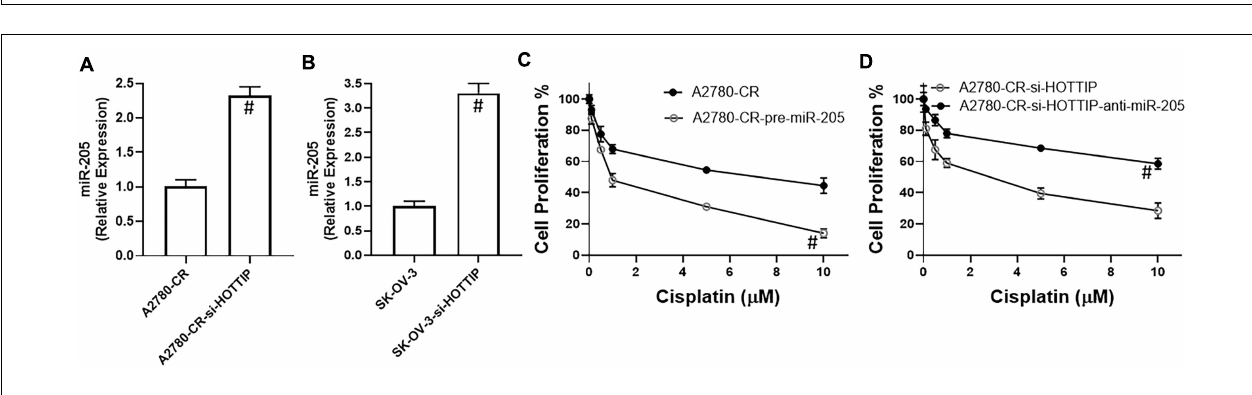
FIGURE 3 | Expression of miR-205 in (A) Cisplatin resistant A2780-CR cells (with and without HOTTIP silencing) and (B) SK-OV-3 cells (with and without HOTTIP silencing) was quantitated using RT-PCR. (C) Cell proliferation for cisplatin resistant A2780-CR with and without pre-miR-205 and (D) cell proliferation for HOTTIP silenced A2780-CR cells with and without anti-R-205, was measured by MTT assay. # p <